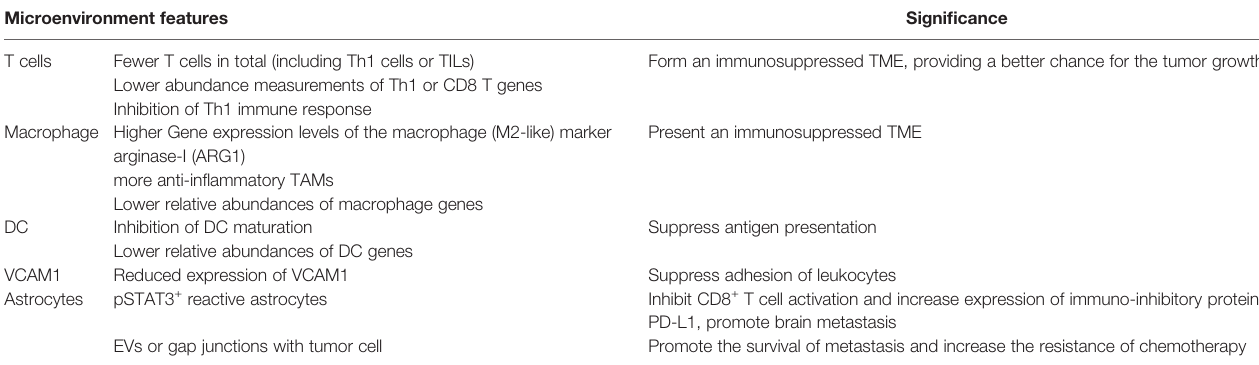
TABLE 2 | Feature of the TME of NSCLC brain metastasis comparing with primary tumor. Microenvironment features Signi fi